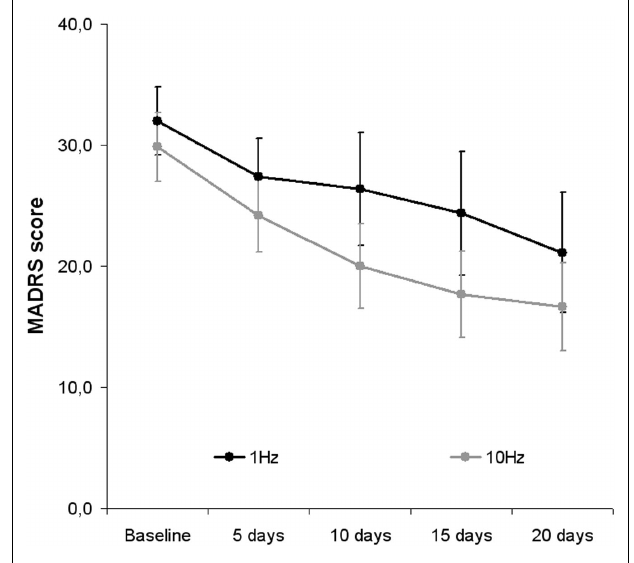
FIGURE 1 | Changes in MADRS scores following rTMS sessions in combination with venlafaxine (150mg) in both groups: 1Hz applied over the right dorsolateral prefrontal cortex (DLPFC)/10Hz applied over the left DLPFC. rTMS: repetitive transcranial magnetic stimulation/MADRS: Montgomery–Asberg Depression Rating Scale Results are given as mean and